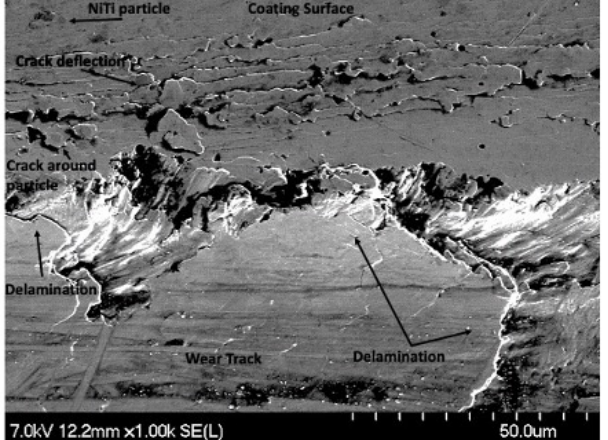
Figure 28. SEM Image of Delamination, Particle Removal and Particle-Crack Interaction on the 100 Pass Wear Track on the 4 μ m Thick Ni-P-NiTi Coating.